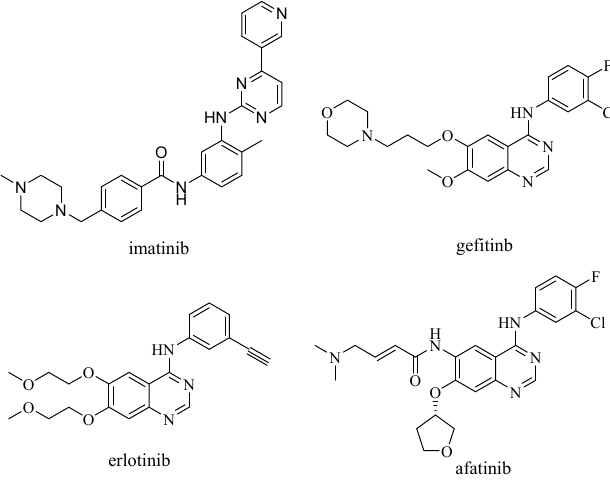
Figure 1. The chemical structure of the selective chemotherapeutic drugs.